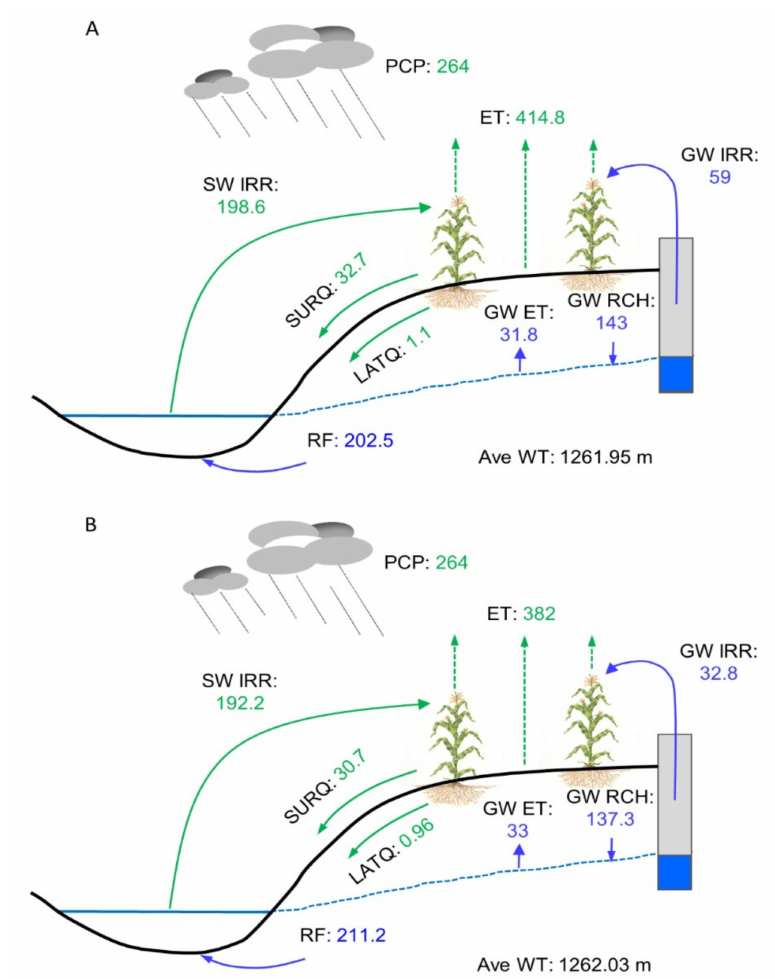
Figure 6. Water budget scheme for the entire study region for ( A ) the baseline scenario and ( B ) the reduced irrigation scenario, with domain-wide values reported in mm and water table elevation reported in